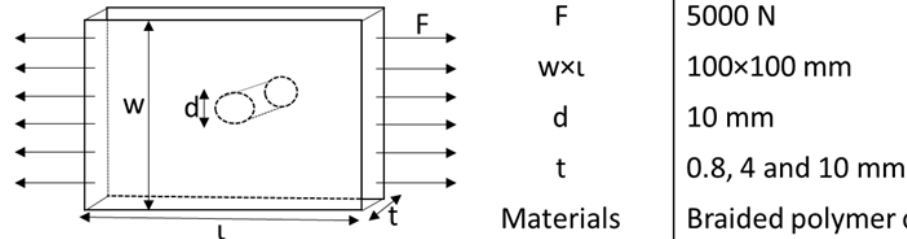
Figure 3. A basic model of the problem definition at the macroscale.